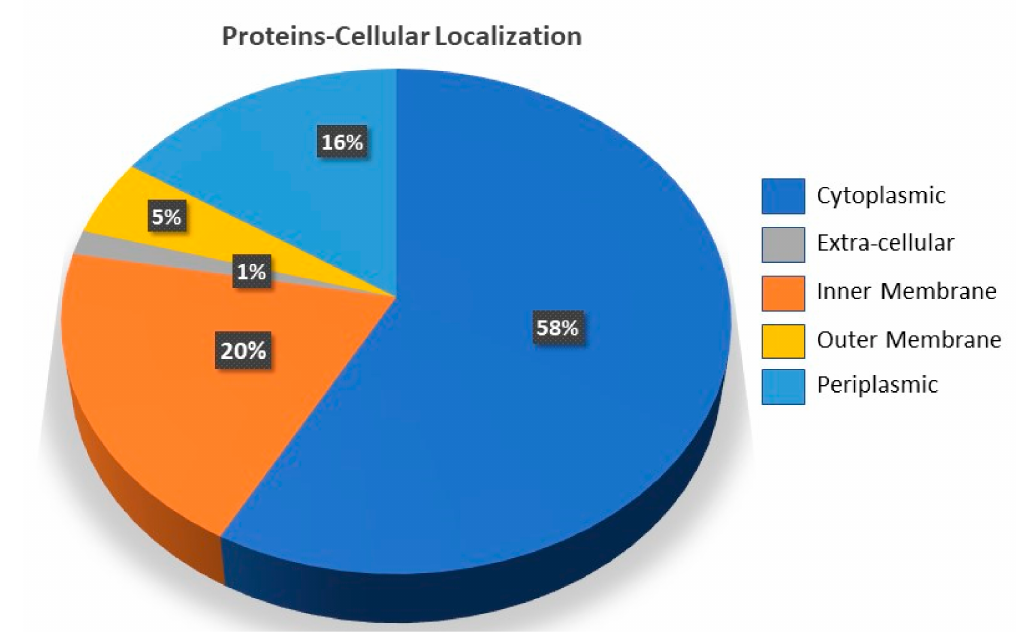
Figure 1. The distribution percentage of each protein based on cellular localization. The different colors represent the percentage of each type of localized proteins in the whole proteome sequence of A. faecalis